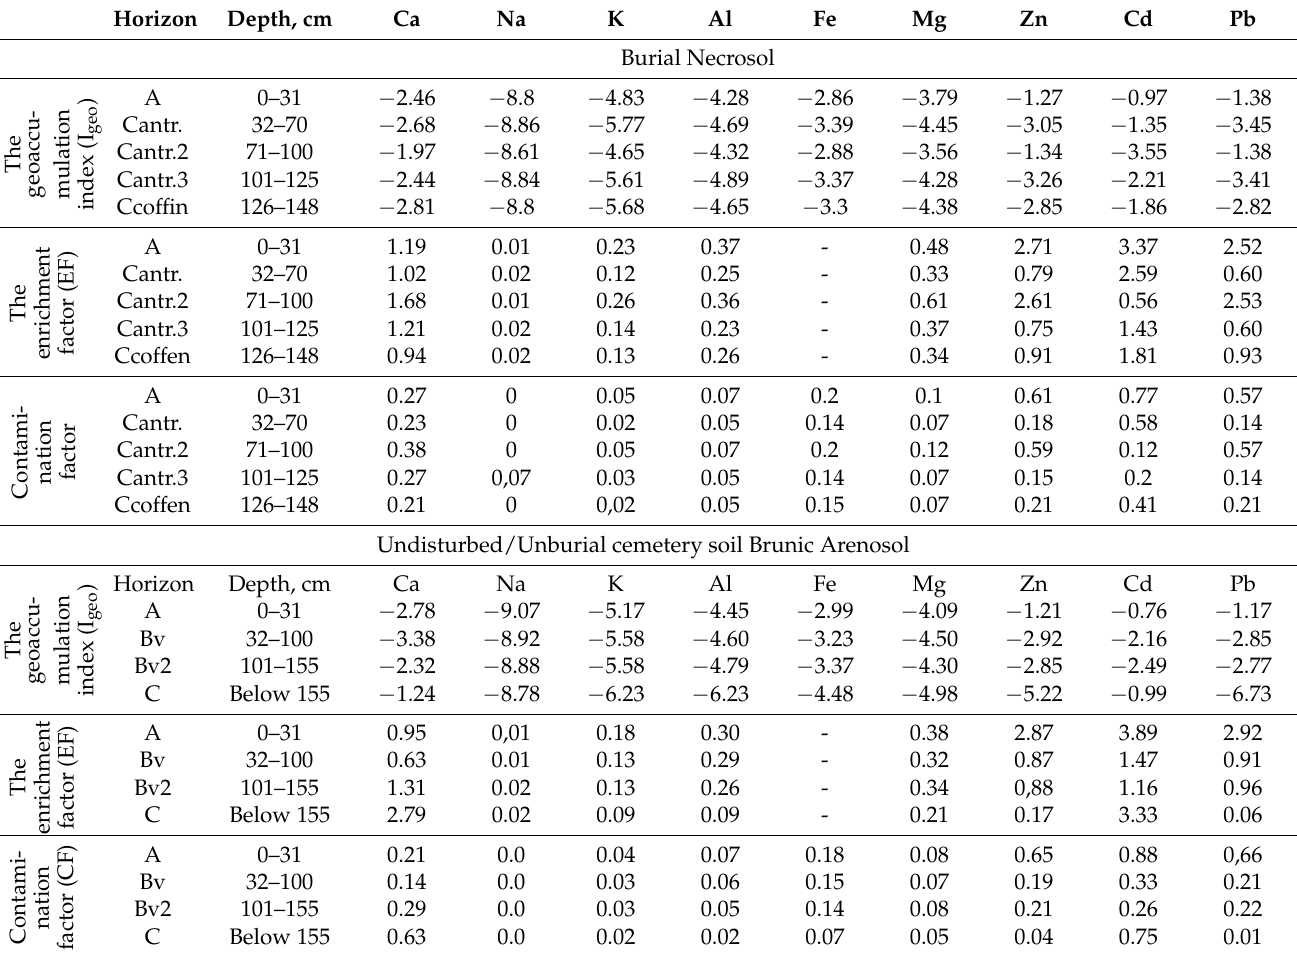
Table 6. The environmental indicators of Burial Necrosol in cemetery of Rud ó wka